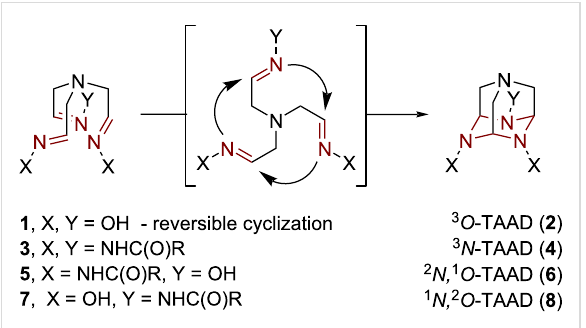
Scheme 1: A general strategy for the assembly of TAAD